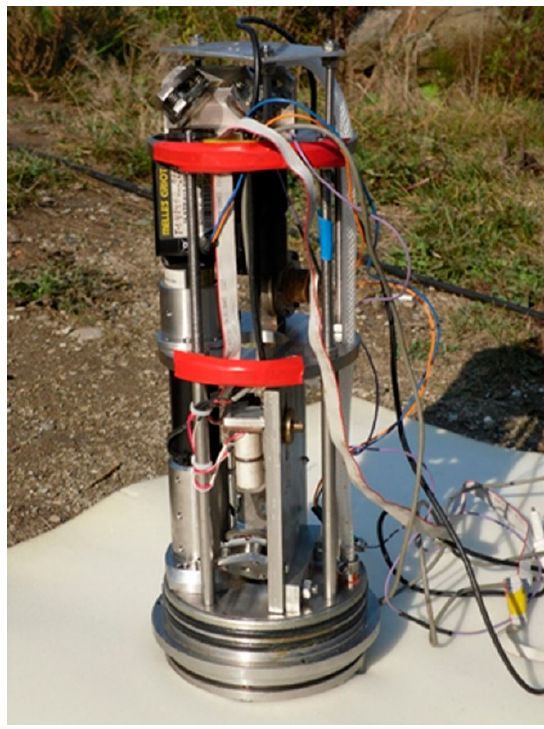
Figure 1. Internal view of supersensitive detector of hydrosphere pressure variations. Sensors 2020 , 20 , x FOR PEER REVIEW